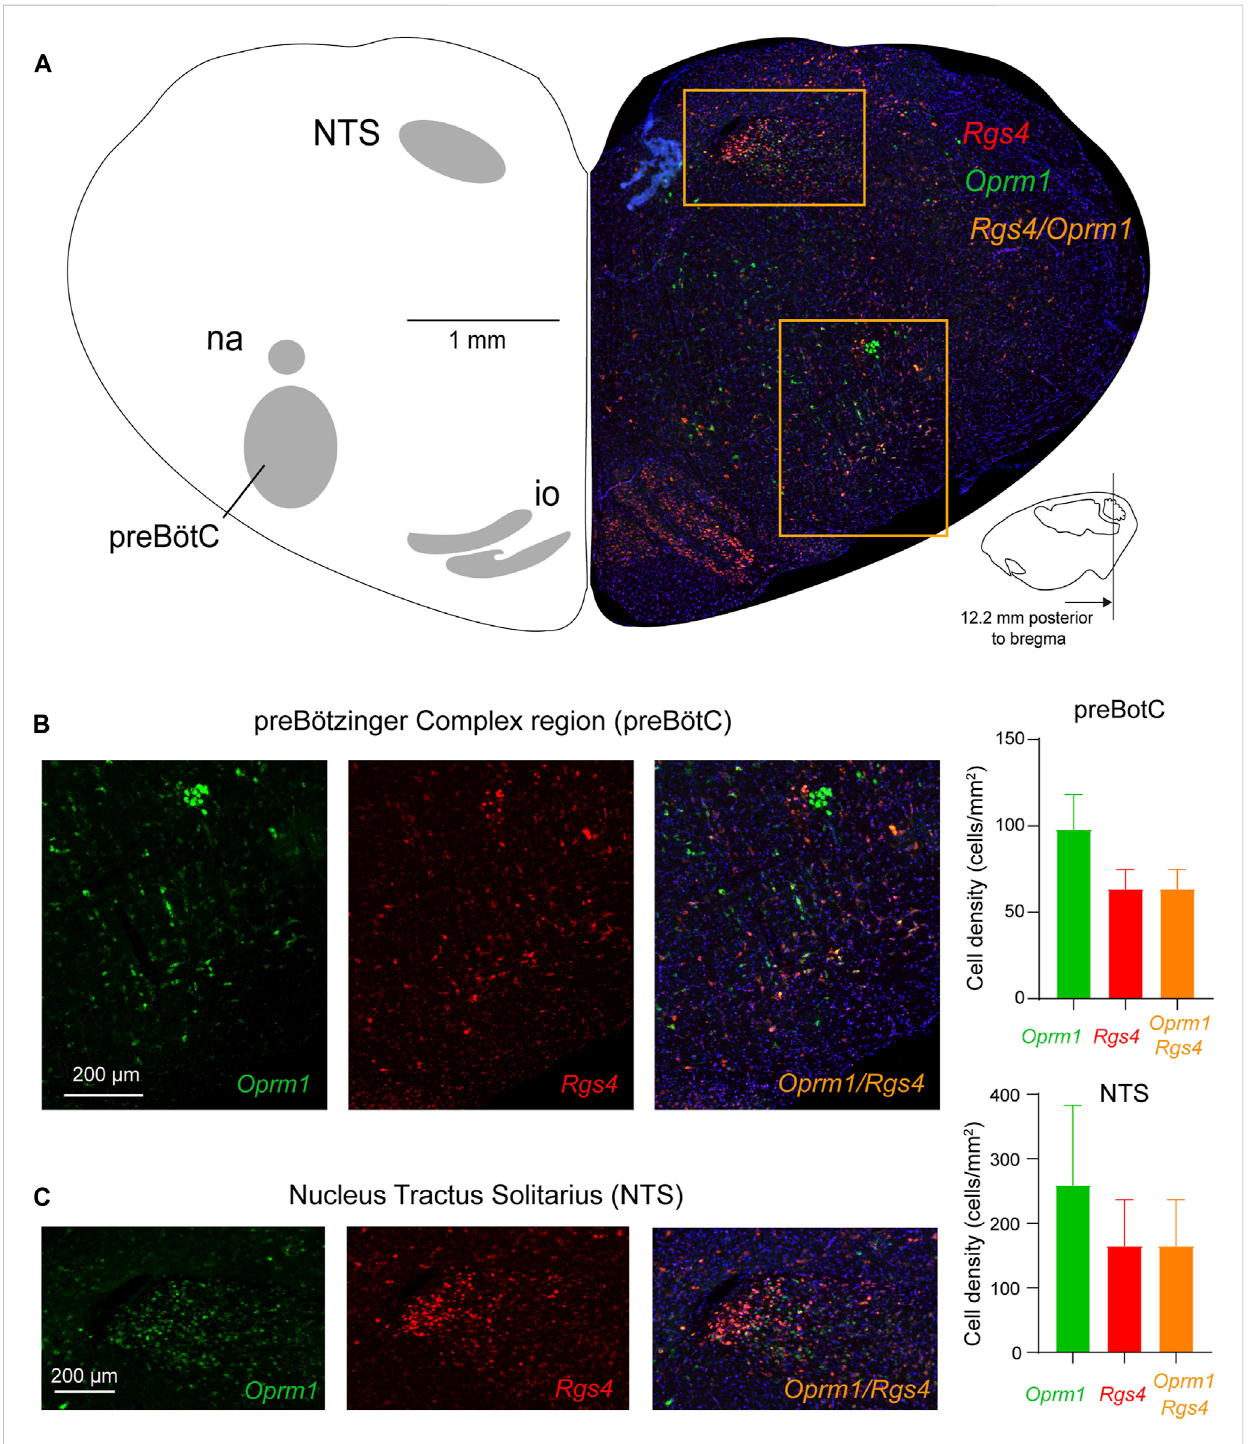
FIGURE 6 Expression of Oprm1 and Rgs4 mRNAsinthepreBötCandNTS. (A) ThepreBötCand thenucleus tractussolitarius(NTS) expressed Oprm1 (thegene coding for MORs, green) and Rgs4 (the gene coding for regulators of G-protein signaling 4, red) mRNAs. (B) Oprm1 and Rgs4 mRNAs were expressed in thepreBötCandmostcellsexpressing Oprm1 alsoco-expressed Rgs4 (orange).Thedensityof Oprm1 -positivecellswasmoderatecomparedtothehigh density of Oprm1 cells in the NTS (C) . In the NTS, cells expressed Oprm1 as well as Rgs4 with substantial co-expression. Rgs4 , mRNA of regulator of G-protein signaling 4. Oprm1 , Gene encoding MORs. NTS, nucleus tractus solitarius. na, nucleus ambiguus. io, inferior